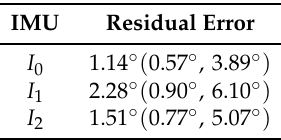
Table 3. Mean (std,max) angular residual errors (cf. Equation (17)) for the hand-eye calibrations of each inertial measurement unit (IMU) I i as calculated on the data sequence used for